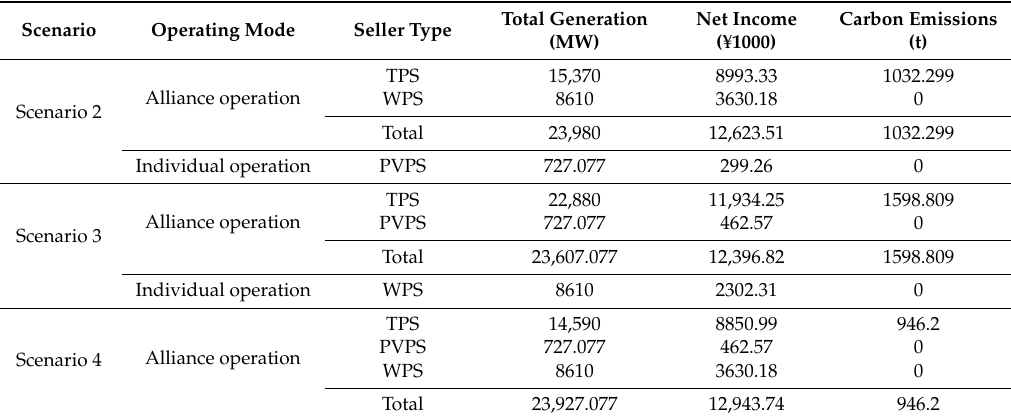
Table 6. Comparison of benefits in the alliance